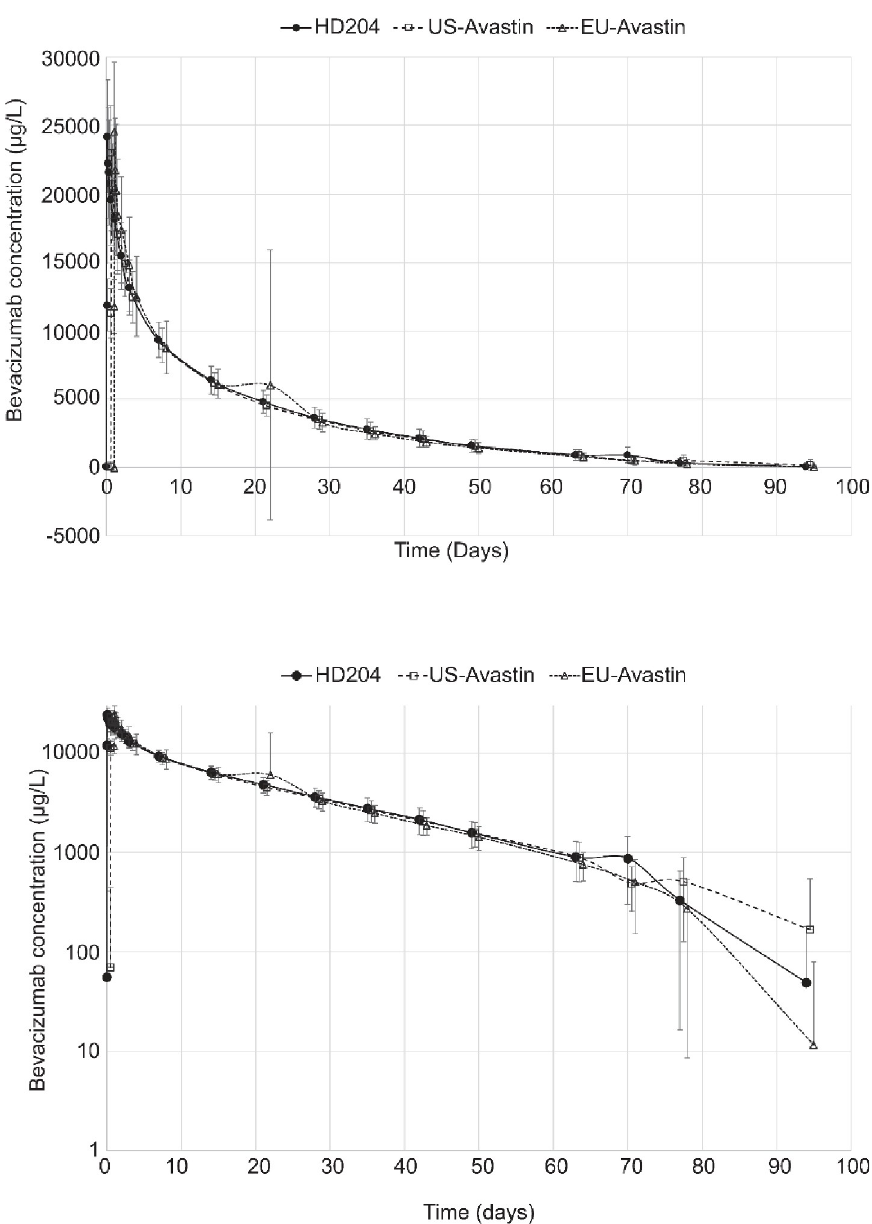
Fig 2. A-B Mean ± SD bevacizumab serum concentration-time profiles. Mean ( ± SD) bevacizumab concentrations over time are shown for all three groups on a linear scale (upper panel) and a semi-logarithmic scale (lower panel). Time 0h = pre-dose; Time 1.5h = end of infusion. Number of subjects with serum concentrations reported at each time are provided in the source table. Notes: Mean bevacizumab concentrations = 0.0 μ g/L are not plotted on the semi- logarithmic graph; the large SD on Day 22 for EU-Avastin is due to one subject with an atypical PK profile; some error bars are not shown on the semi-logarithmic graph as negative values cannot be plotted logarithmically. Mean ( ± SD) of bevacizumab concentrations over time are shown for all three groups on a linear scale (upper panel) and a semi-logarithmic scale (lower panel). Time 0h = pre-dose; Time 1.5h = end of infusion. The number of subjects with serum concentrations reported at each time points is provided in the source table.